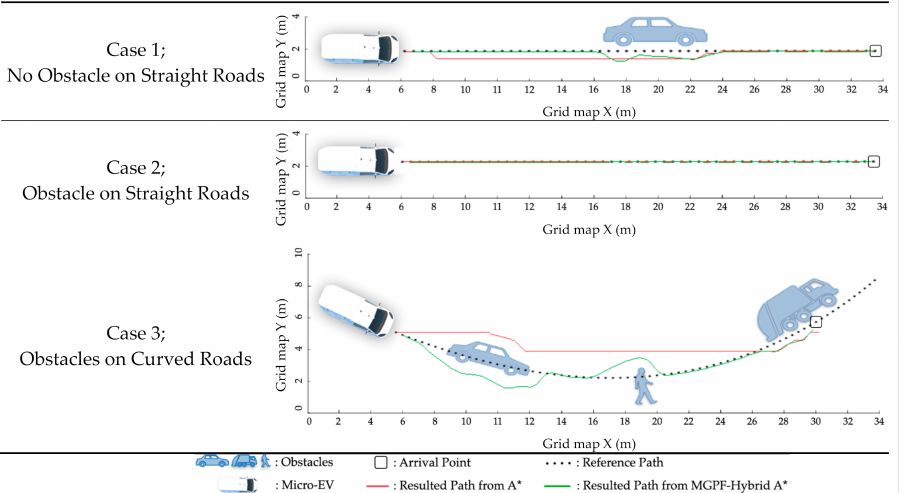
Figure 12. Performance evaluation of A* and MGPF-Hybrid A*. The generated paths are drawn on a grid